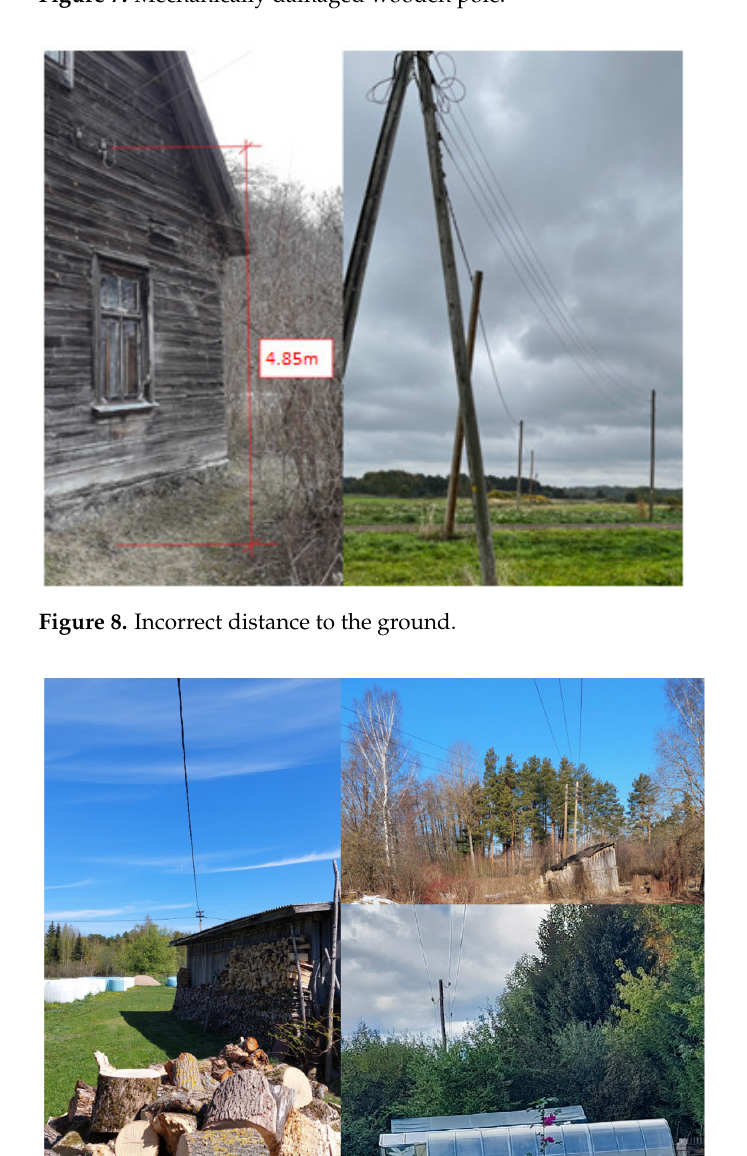
Figure 7. Mechanically damaged wooden pole.